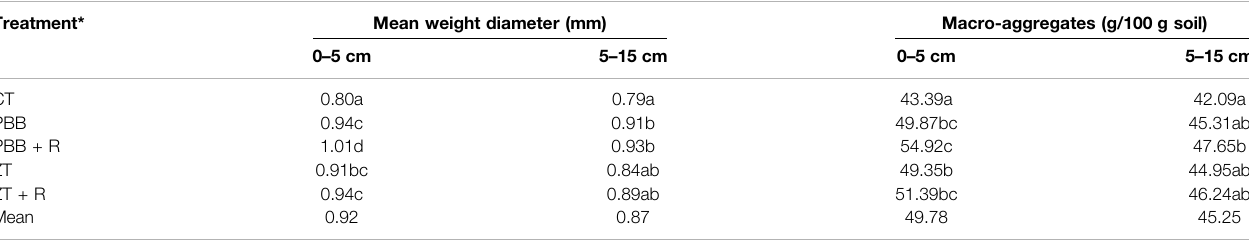
TABLE 3 | Macro-aggregates and mean weight diameters of soil aggregates in 0 – 5 and 5 – 15 of soil layers.